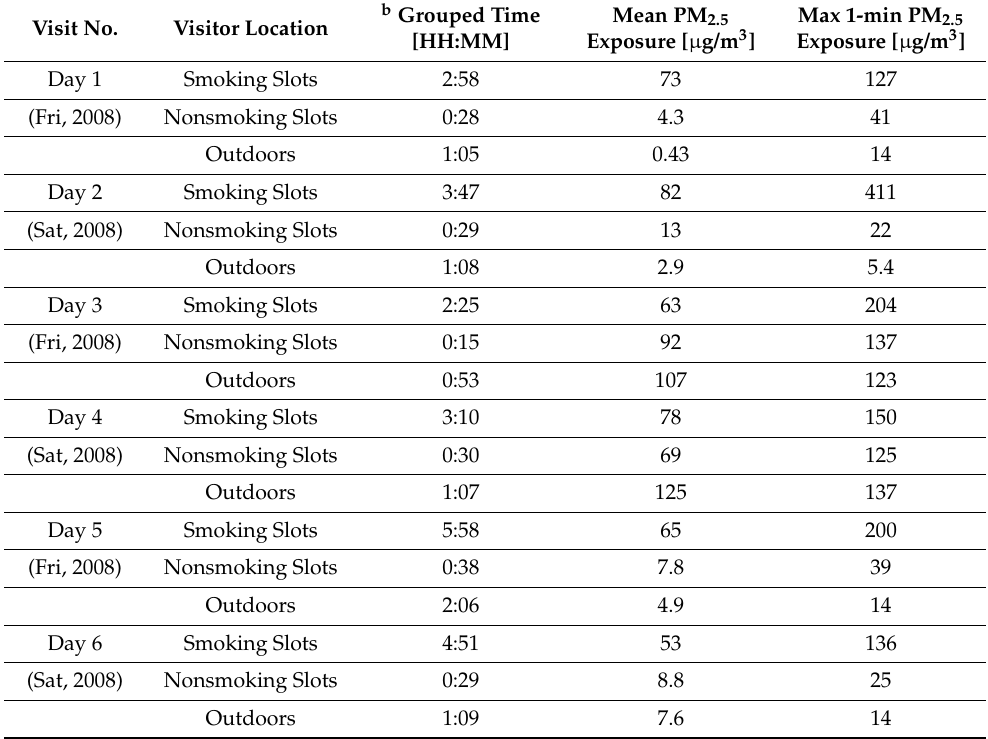
Table S5. Mean and maximum 1-min personal PM 2.5 exposures for visitors in 2008 acting as patrons a . Visit